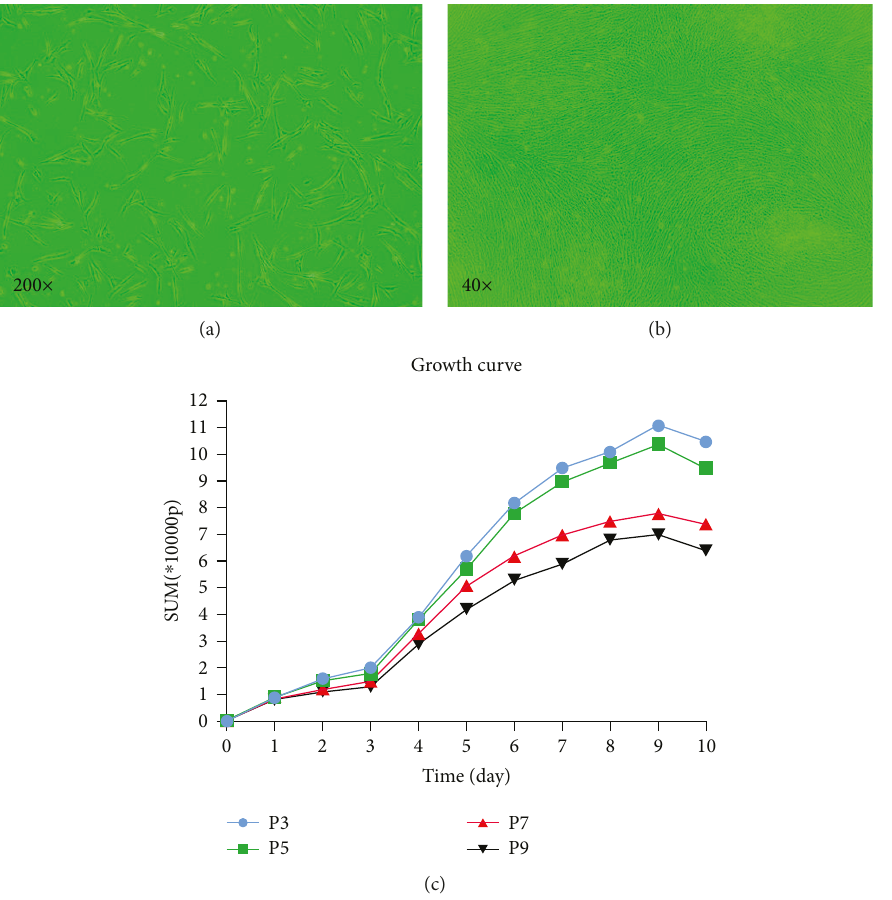
Figure 1: (a) (200x) Cells were elongated or long fusiform. (b) (40x) The cells were spirally divergent. (c) The growth curve of the 3rd, 5th, 7th, and 9th passage